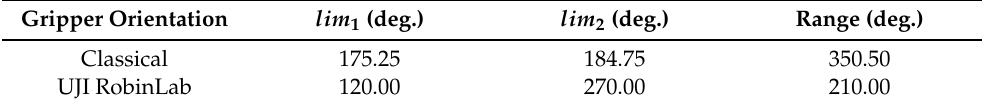
Table 1. Joint range comparison.